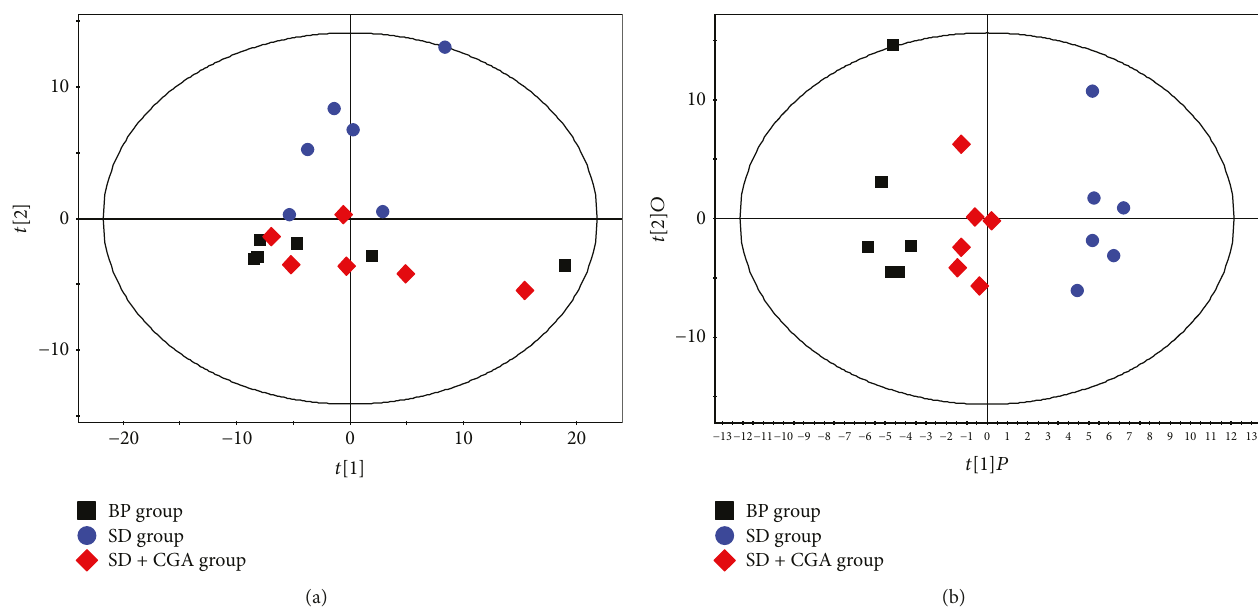
Figure 3: PCA and OPLS-DA score plot derived from the GC-MS analysis of urine from BP, SD, and SD+CGA